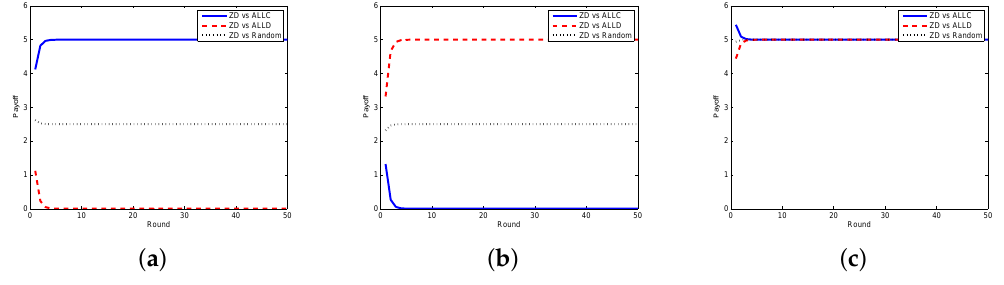
Figure 4. Payoffs with ZD vs. ALLC/ALLD/Random in the discrete model. ( a ) requestor’s payoff; ( b ) worker’s payoff; ( c ) social welfare.